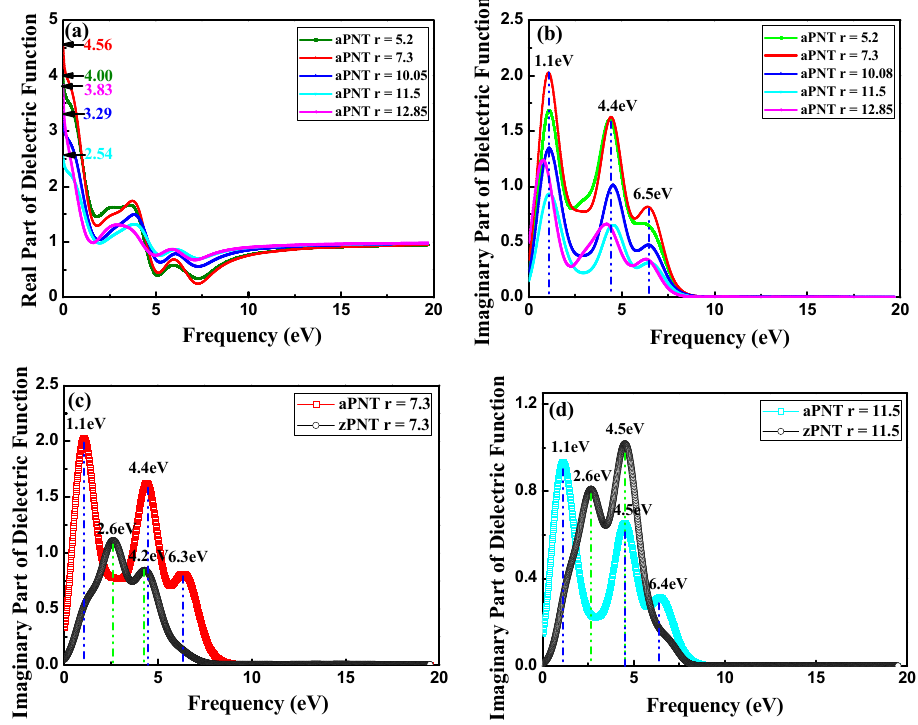
Figure 9. Dielectric functions: ( a ) Real (Re) part and ( b ) imaginary (Im) part for aPNTs with different radii; ( c ) Real (Re) and ( d ) imaginary (Im) parts of the dielectric function for aPNTs and zPNTs with the same radius.